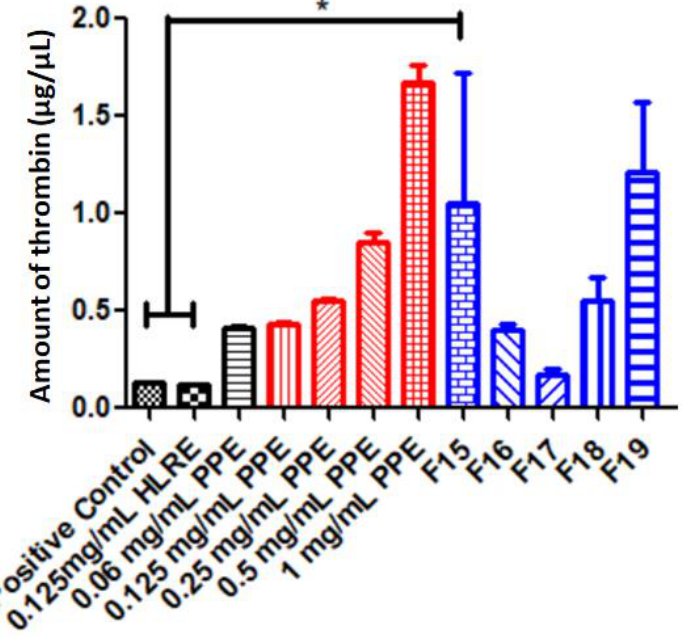
Figure 5. Thrombin activity of HLRE, PPE, and the gels containing both extracts (with different PPE concentrations), n = 3. * indicates significant difference at p < 0.05.